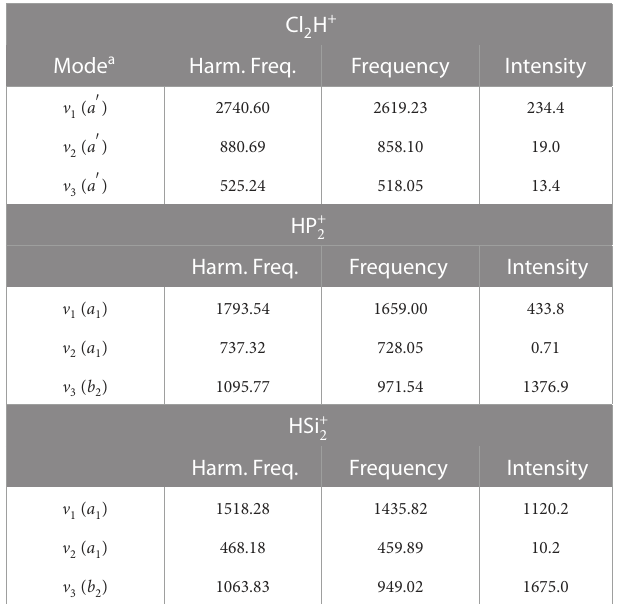
TABLE3 Harmonicandanharmonicvibrationalfrequencies(cm −1 )forCl 2 H + , HP 2 + ,and HSi 2 + .Anharmonicintensitiesinkmmol −1 .Allquantitiesareatthe